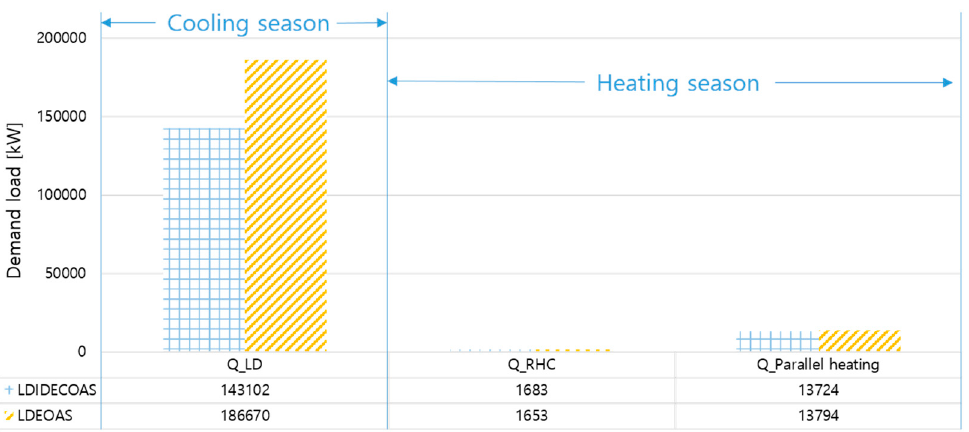
Figure 7. Annual thermal load demand of each component.